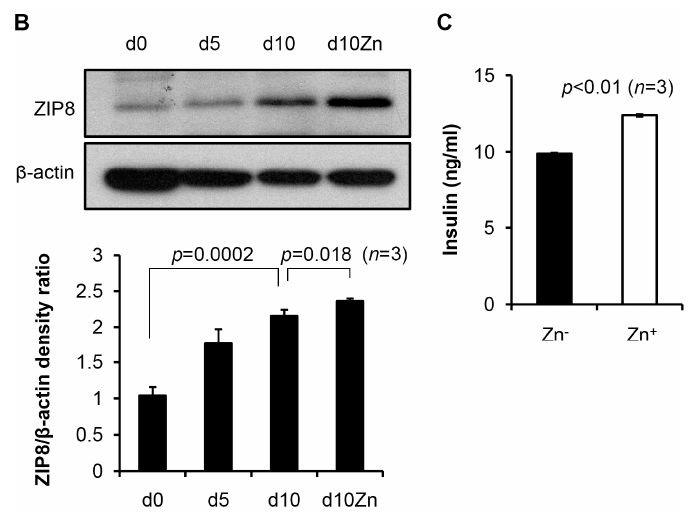
Figure 4. Zn supplementation affects the production and secretion of insulin and the expression of ZIP8 in SHED- β cells. ( A ) Immunofluorescence staining of insulin (indicated by red color and white arrow heads) in SHED- β cells with or without zinc supplementation. Note the more prominent expression of insulin after zinc supplementation in the merged panel; ( B ) Western blot analysis of ZIP8 expression in different time points with or without zinc supplementation; ( C ) Constitutive secretion of insulin from SHED- β cells evaluated by ELISA on n = 3. In these assays, 50 µM of zinc was supplemented.